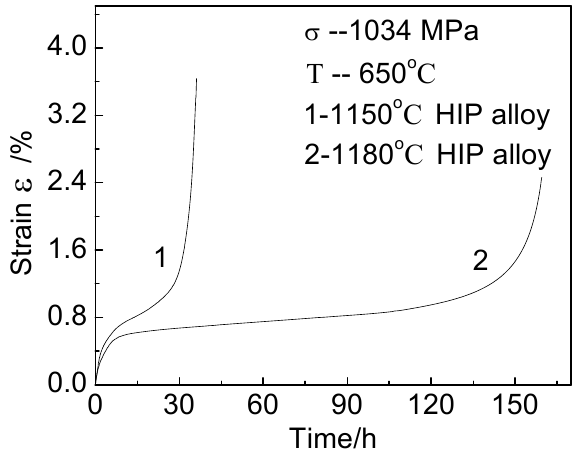
Figure 5. Creep curves of the alloys after HIP treated at different temperatures and full heated treated.